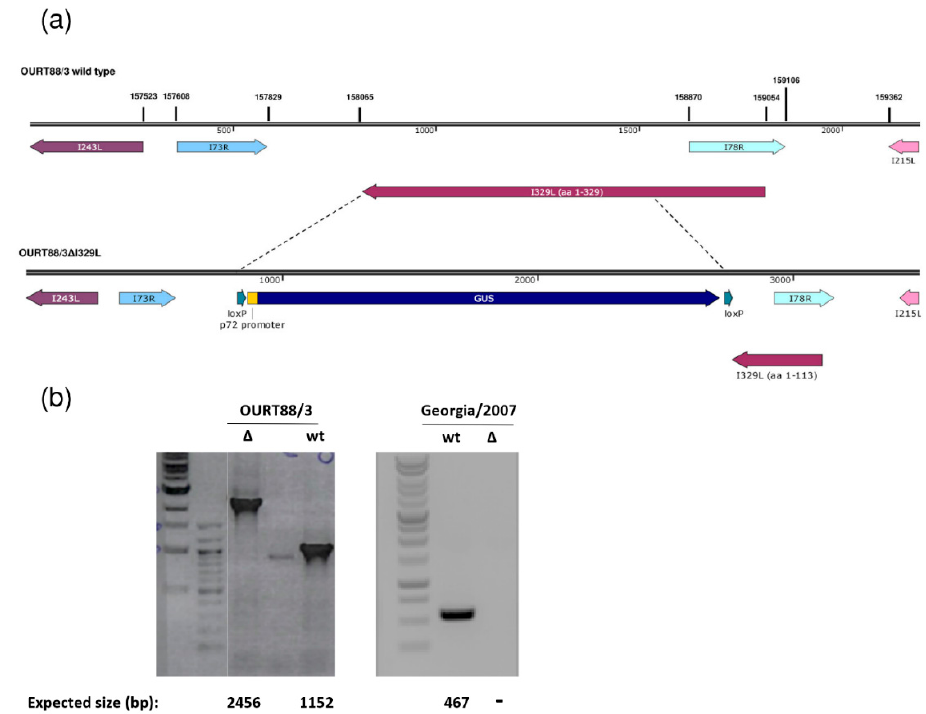
Figure 1. Deletion of the I329L gene from the OURT88 / 3 and Georgia 2007 / 1 genomes. ( a ) The position and direction of the I329L gene and neighbouring genes on the wild-type OURT88 / 3 genome are shown on the top panel. Arrows indicate the direction in which the genes are read. The bottom panel shows details of the construction of the I329L gene deletion. The β -Glucoronidase (GUS) gene under control of the African swine fever virus (ASFV) B646L gene promoter and flanked by loxP sites was used to replace the I329L gene, excluding the portion encoding residues 1 to 113. This fragment was retained to avoid disrupting the overlapping I78R gene, which is read from the opposite strand. ( b ) Analysis of genomic viral DNA by PCR. Viral DNA was extracted from wild-type (wt) and delta I329L ( ∆ ) viruses. Specific fragments were amplified by PCR and the products were analysed by agarose gel electrophoresis. For OURT88 / 3, the fragments encompassing the flanking regions of the I329L deletion are shown and the expected fragment sizes are indicated below each lane. For Georgia 2007 / 1, a fragment within the deletion was obtained for the wt but not for the deletion mutant virus as expected.